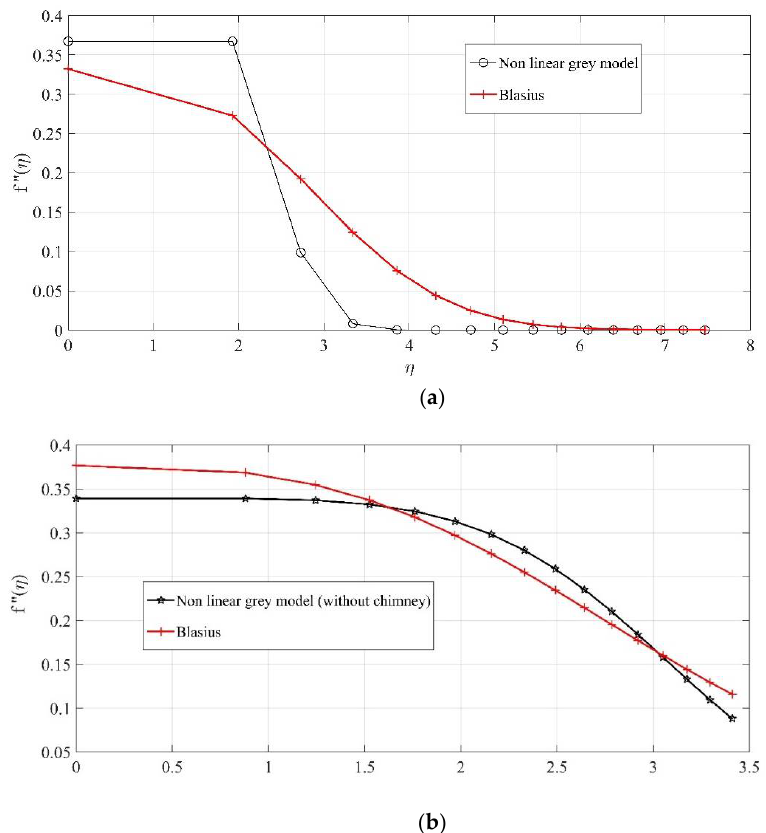
Figure 5. The plot of the second derivative ( f ″( η )) with the stretching factor: ( a ) chimney, ( b ) without chimney.